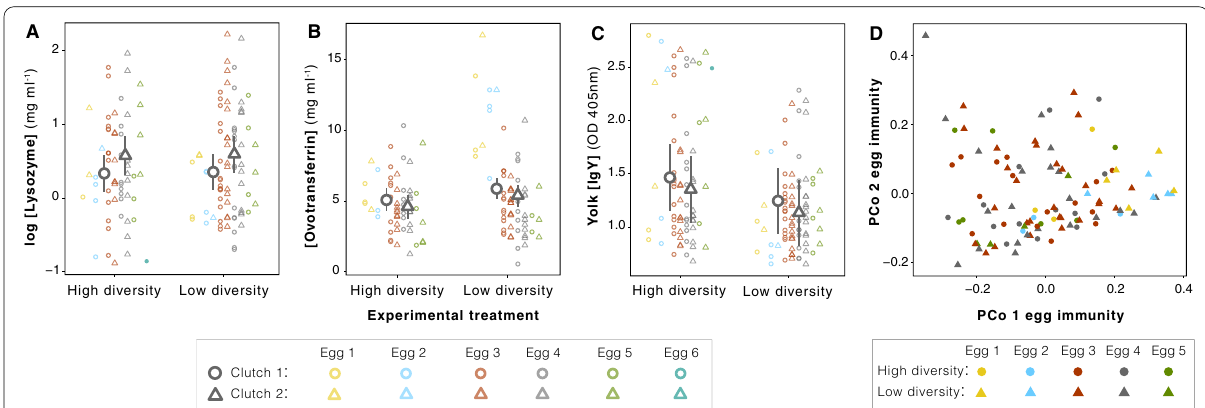
Fig. 2 Experimental microbial environmental effects on egg immune function. A Lysozyme concentration (mg ml − 1 ; log scale), B Ovotransferrin concentration (mg ml − 1 ), C IgY concentration in yolk (OD 405nm ), and D the first two principal coordinate axes of a multivariate immune index that represents the variation of the indices presented in A – C . Individual egg samples are presented by laying sequence (color) and stratified by clutch number (shape in A – C ) or treatment (shape in D ). None of the egg immune indices were significantly different between the two experimental microbial environments (Table